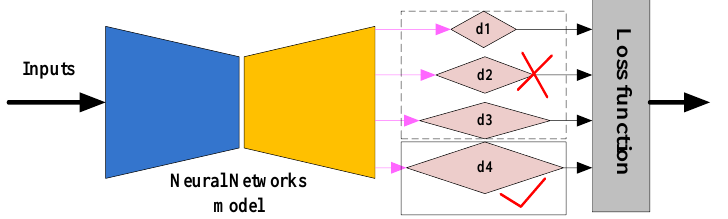
Figure 11. Comparison of largest scale loss and multiscale loss. Previous related work [39,43–45,47,52,57] mainly used four scale disparity maps (d 1 , d 2 , d 3 and d 4 ) to calculate the loss, but we find that it is better to choose the largest scale disparity map (d 4 ).